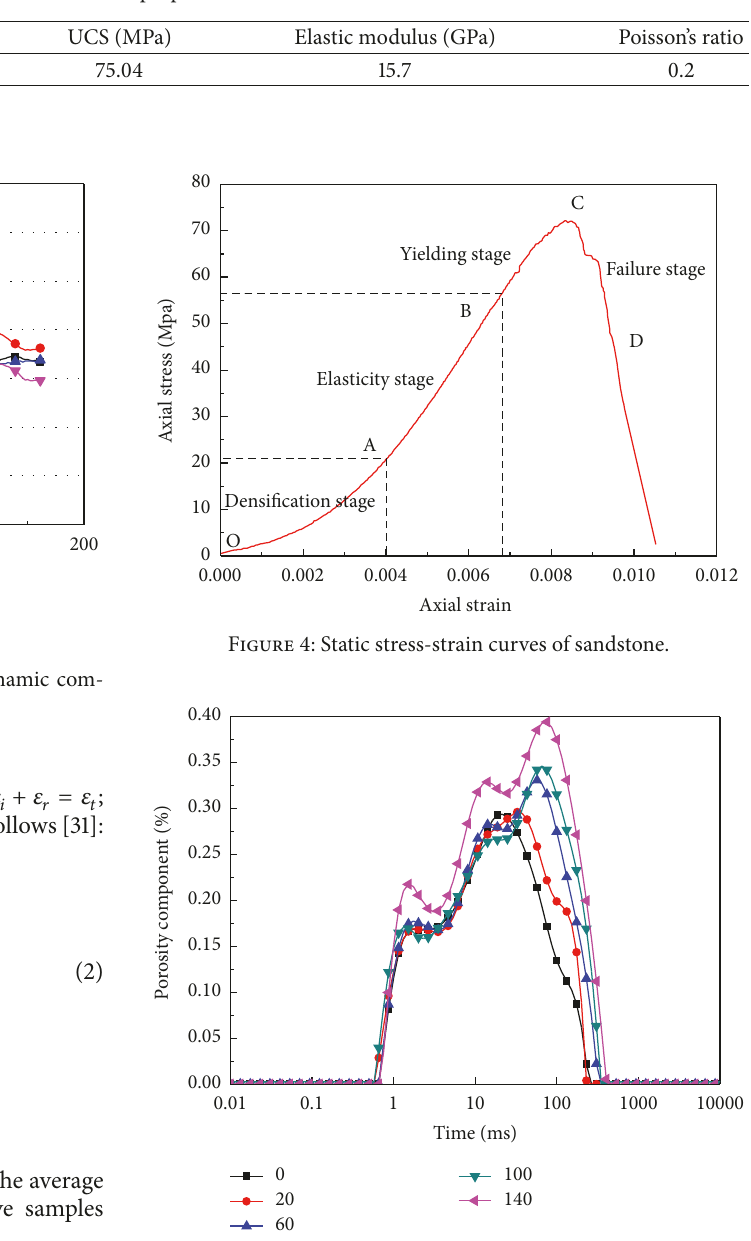
Table 1: Static mechanical properties of sandstone.